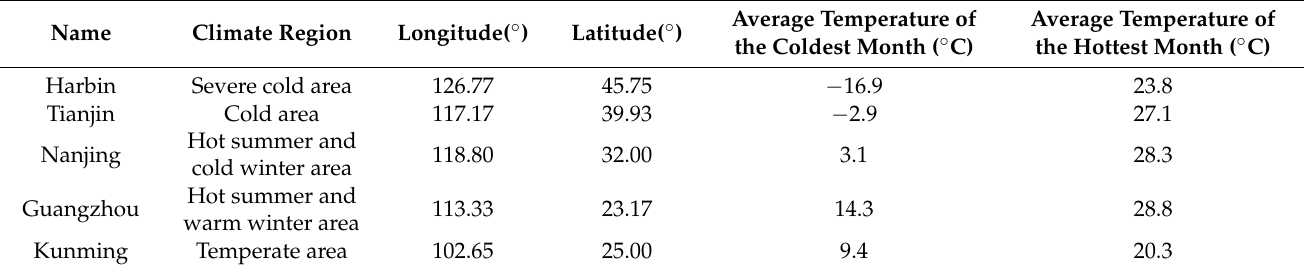
Table 3. Basic Parameters of Typical Cities in Five Climate Zones of